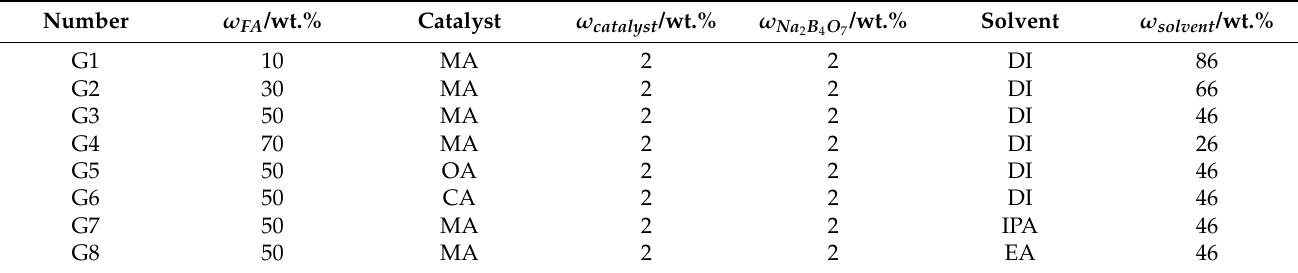
Table 1. The formulations of the FA